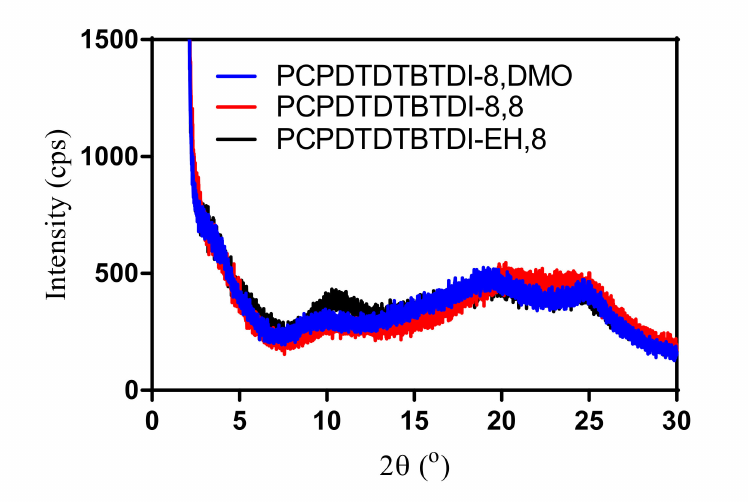
Figure 4. Powder XRD of PCPDTDTBTDI-8, DMO, PCPDTDTBTDI-8, 8, and PCPDTDTBTDI-EH,